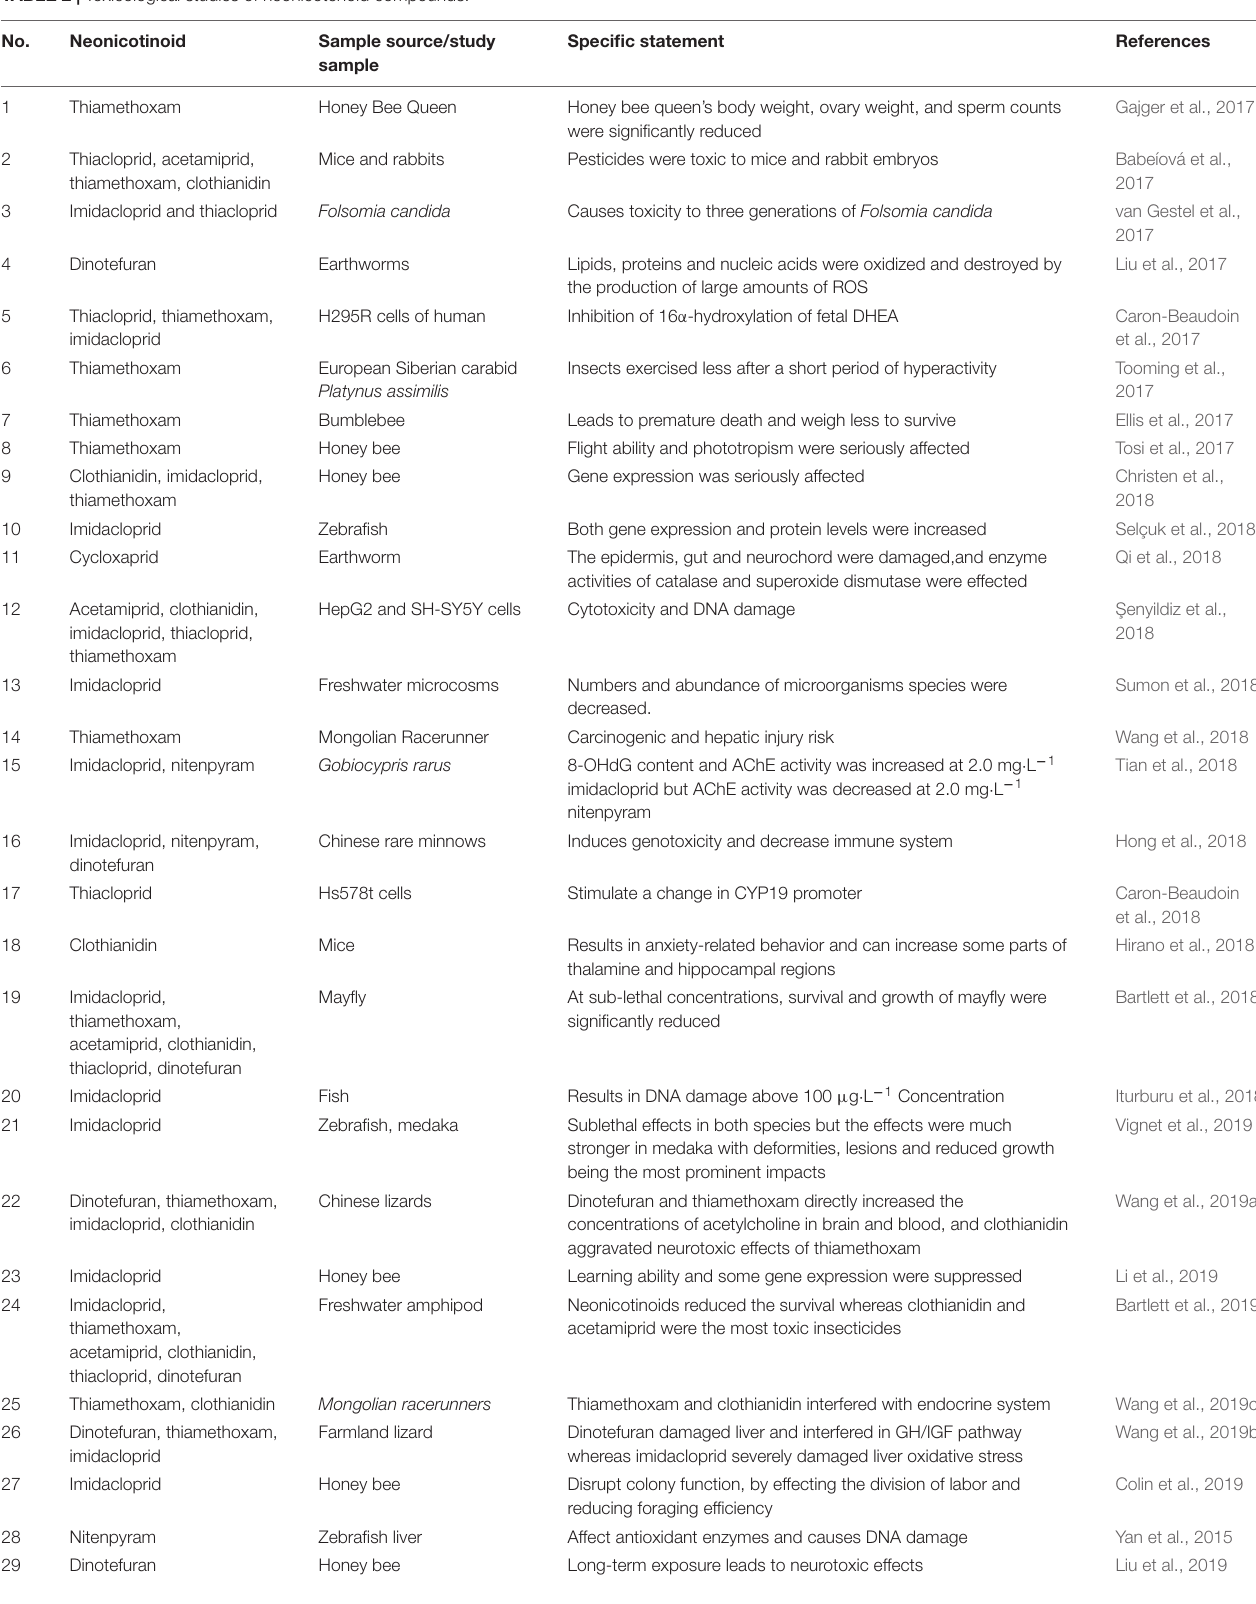
TABLE 2 | Toxicological studies of neonicotenoid